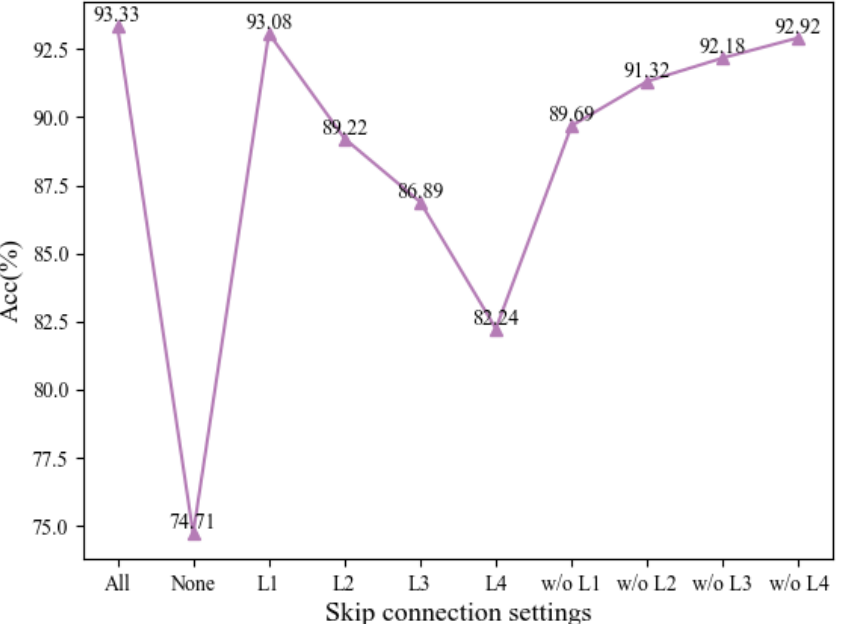
Figure 5. Analysis of different levels of U-Net fusion features. All, original U-Net; None, no skip connection; L1, only the first-level skip connection was included; w/oL1, only first-level skip connection was